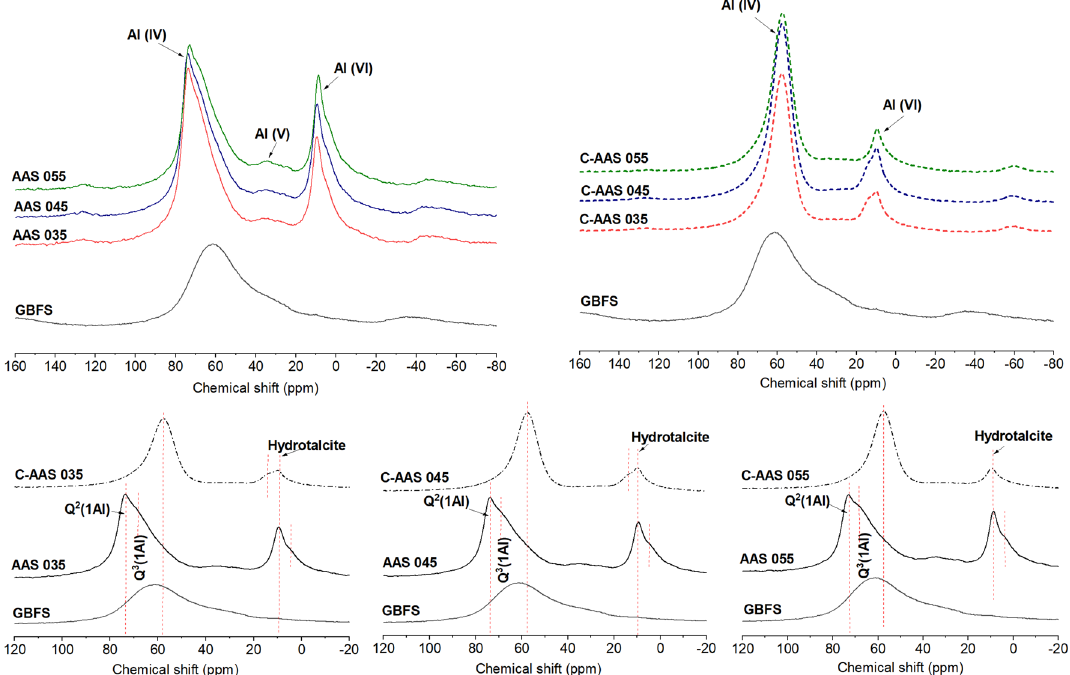
Figure 5. 27 Al MAS NMR spectra of anhydrous slag (GBFS), uncarbonated alkali activated slags at 28 days of curing (AAS), and carbonated alkali activated slag after 28 days of carbonation with 1% CO 2 and 60% RH (C-AAS) at different water to binder